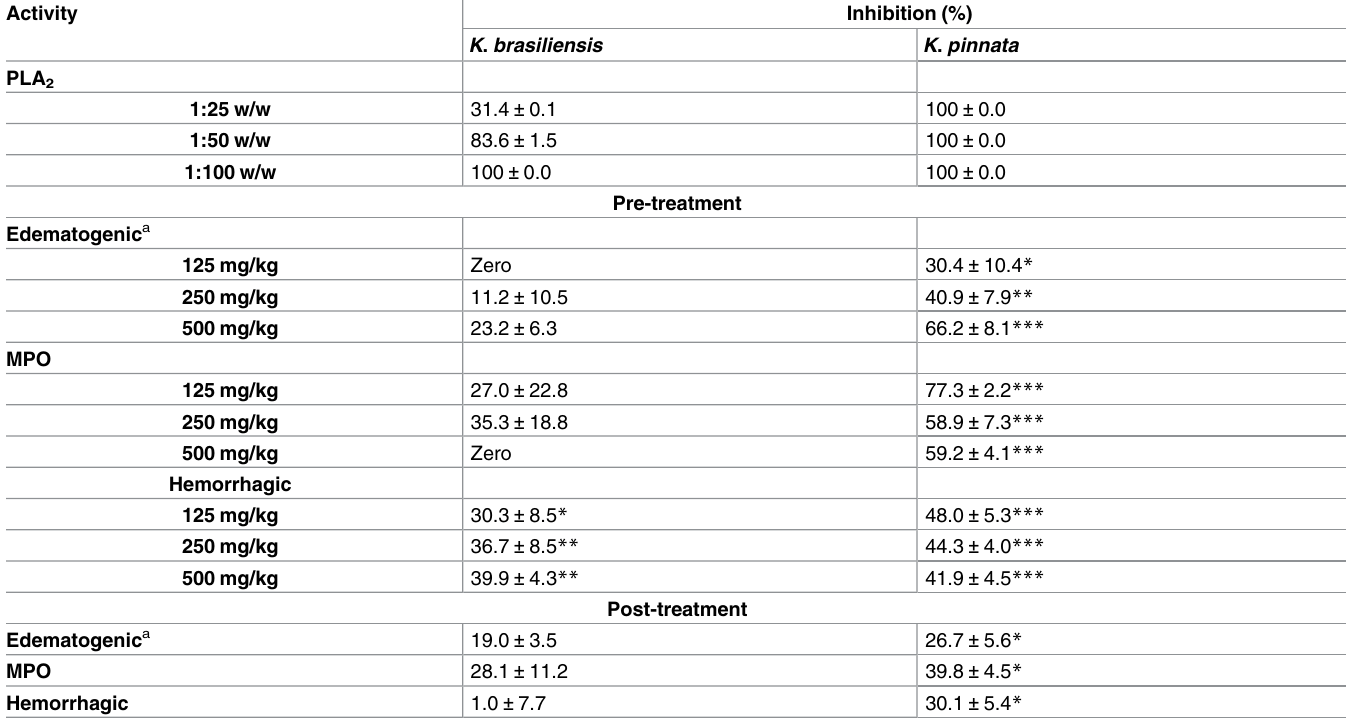
Table 1. Inhibition of the enzymatic and biological activities of B . jararaca venom by hydroethanolic extractsof K . brasiliensis and K . pinnata .